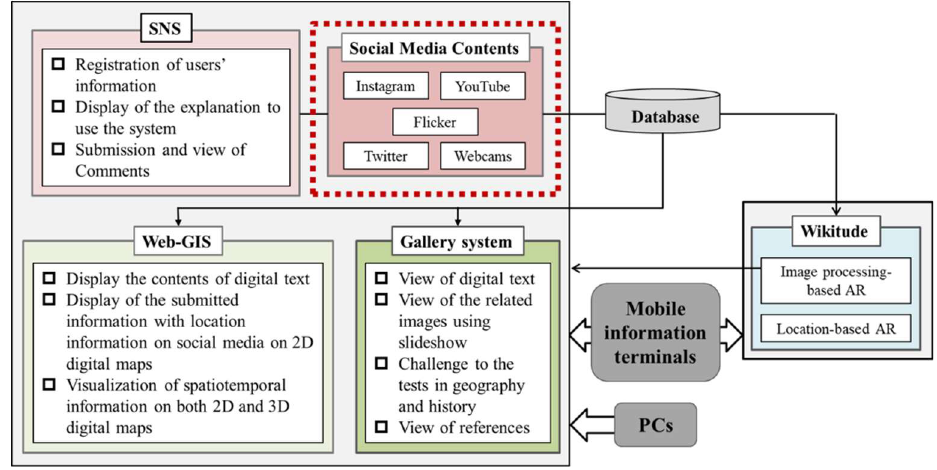
Fig. 2. System design of spatiotemporal information